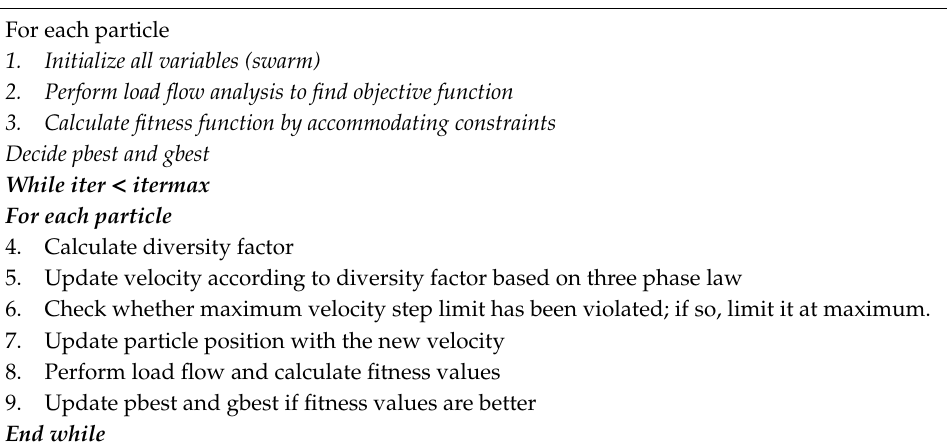
Algorithm 1 Pseudo-code for